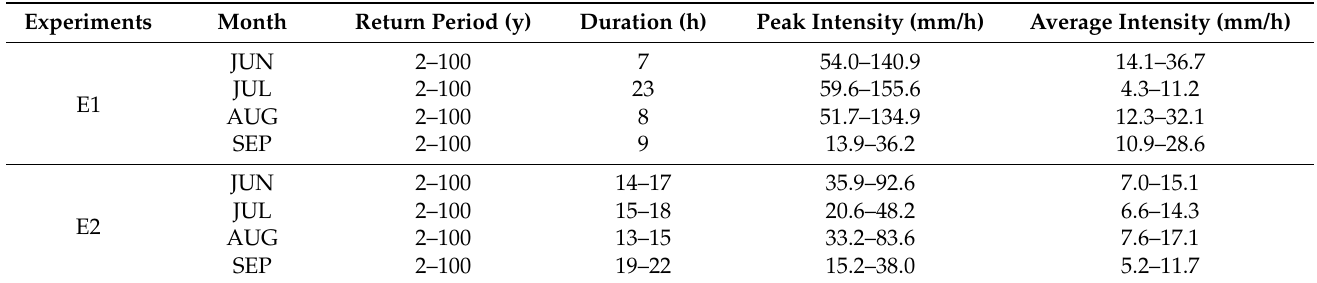
Table 6. Extreme and average rainfall patterns